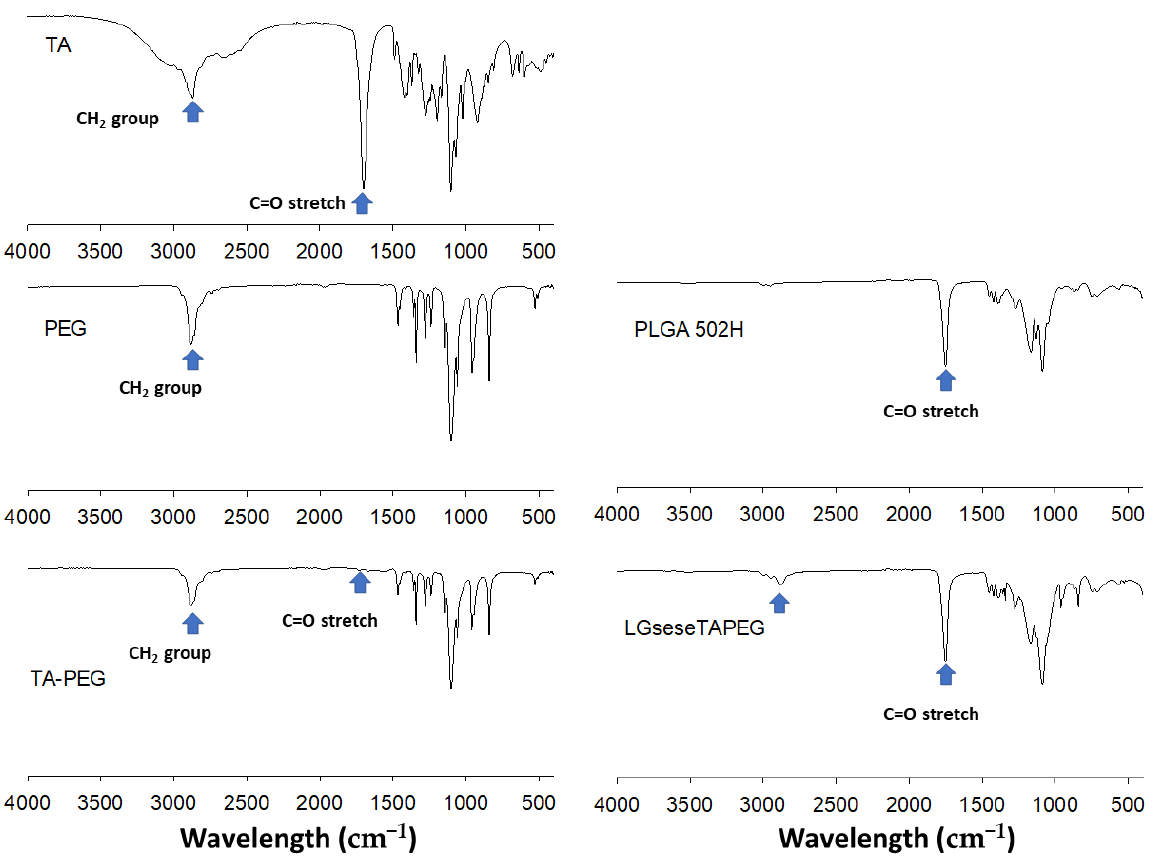
Figure 2. FT-IR spectra of LGseseTAPEG copolymer.